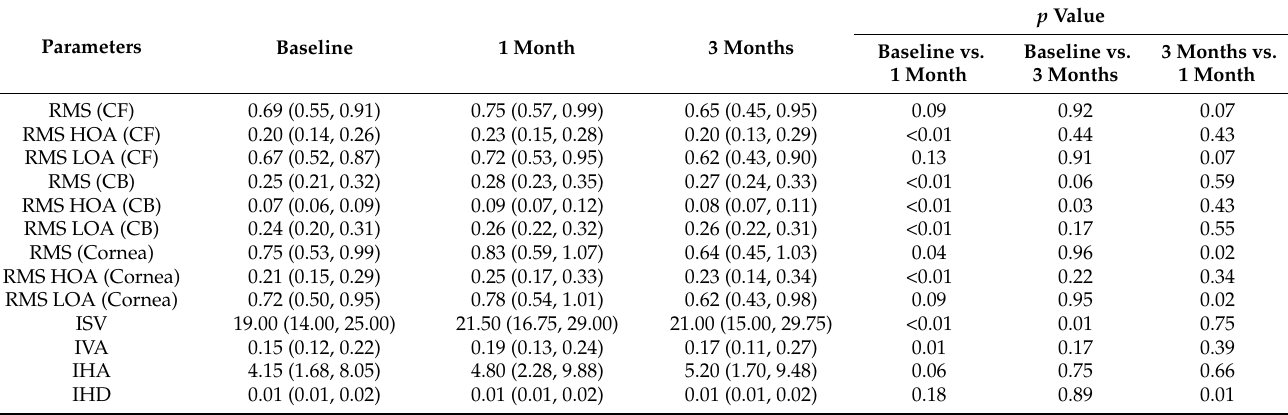
Table 3. Comparison of the total, higher-order and lower-order aberrations of the total, anterior and posterior surface of the cornea before and after cataract